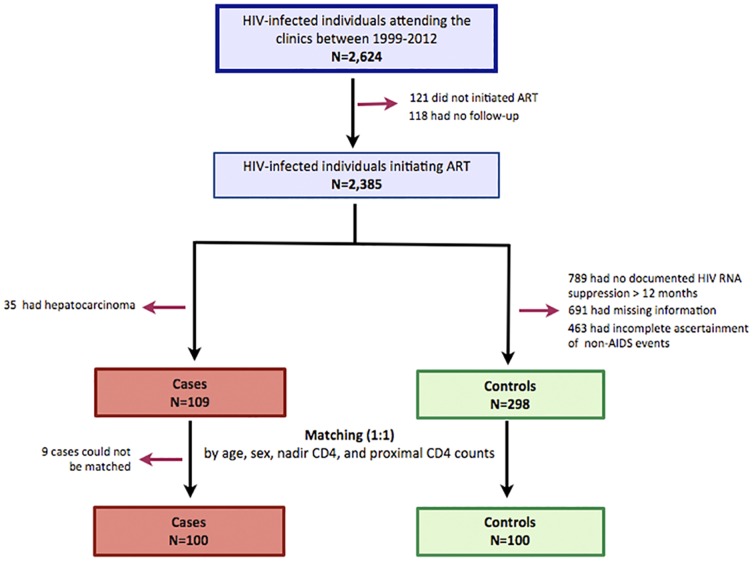
Selection of study participants.